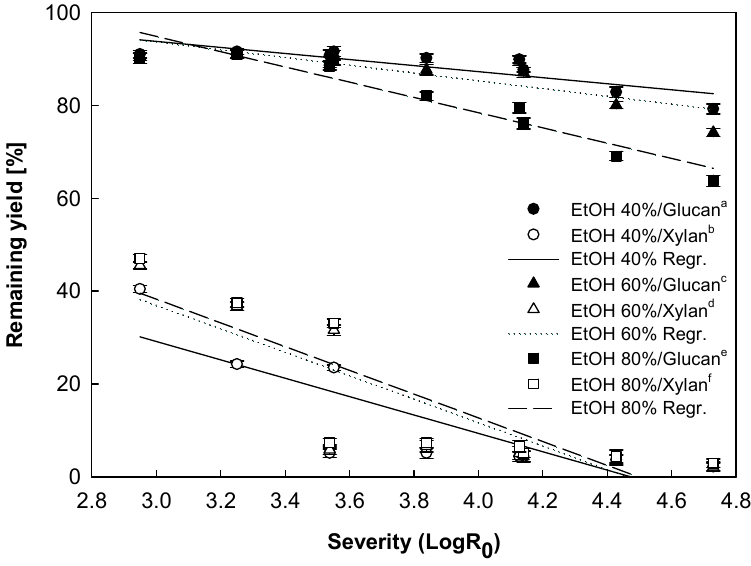
Figure 3. Remaining glucan and xylan yields with reaction severity (log R 0 from 2.95 to 4.73) and ethanol concentration. Reaction conditions: 150 °C, 170 °C, and 190 °C for temperature; 30 min, 60 min, and 120 min for time; and 40%, 60%, and 80% for ethanol concentrations; solid:liquid = 1:10; 0.25 wt.% sulfuric acid concentration. Note the regression equations: a : y = − 6.5 x + 113.2, b : y = − 19.8 x + 88.5, c : y = − 8.4 x + 118.8, d : y = − 25.2 x + 112.5, e : y = − 16.4 x + 144.0, and f : y = − 25.5 x + 114.9. Table 3. Effects of reaction temperature, time, and ethanol concentration on sugar and byproduct concentrations in liquid hydrolysate. Reaction Conditions